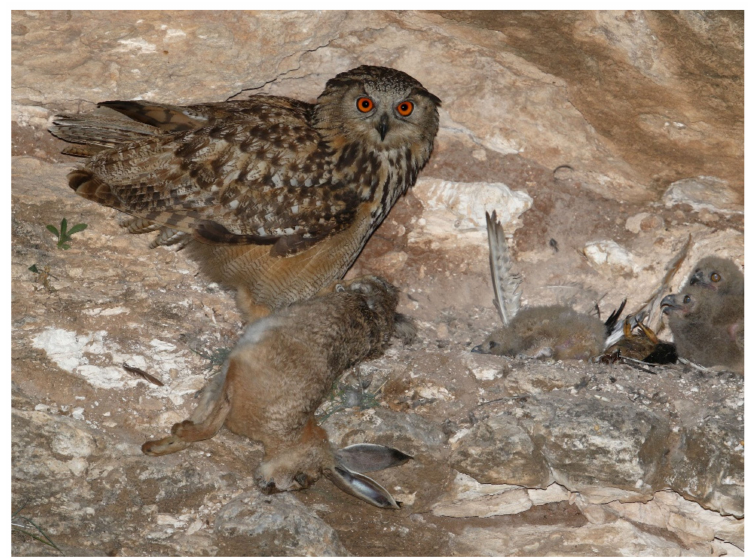
Figure 5. Adult Eagle Owl ( Bubo bubo ) brings a Cape Hare ( Lepus capensis ) to its’ nestlings. Note remains of a Common Kestrel ( Falco tinnunculus ) in the background. Photo: Ezra